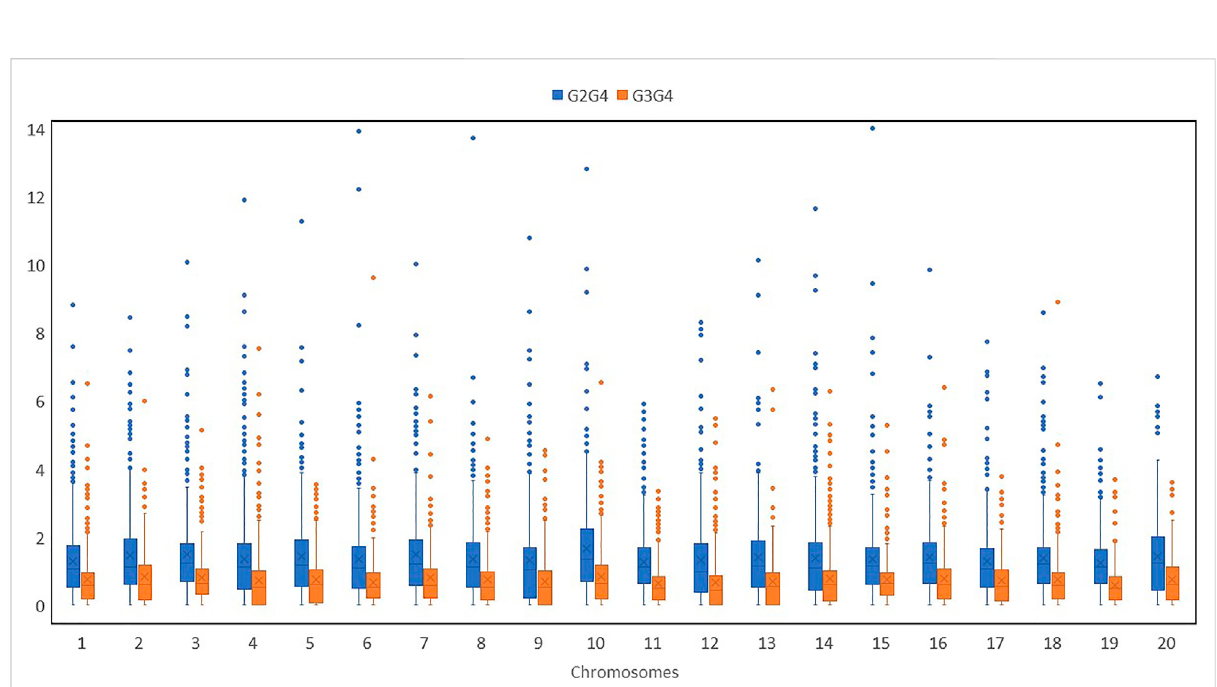
FIGURE 2 Boxplotsof various chromosomes depicting nucleotide diversity ratios ( π buttercup / π mammoth and π hubbard / π mammoth )of thebuttercup to hubbard and mammoth